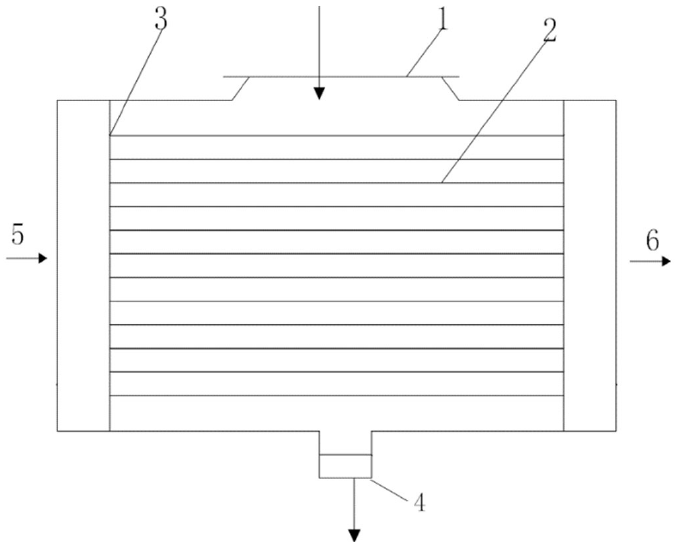
Figure 1. Simple model of a marine ST (1: exhausted steam inlet; 2: heat transfer tubes; 3: tube sheet; 4: condensed steam outlet; 5: cooling water inlet; 6: cooling water outlet).